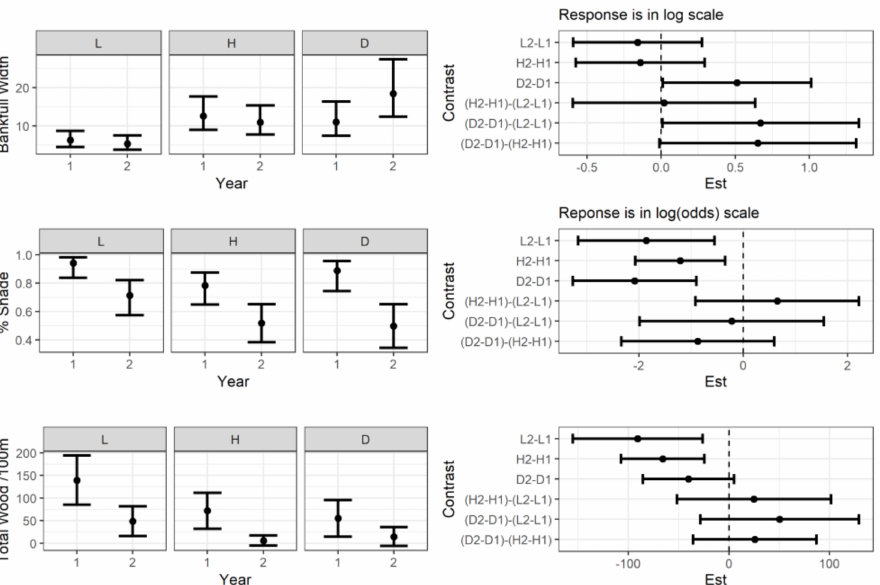
Figure 2. Estimated marginal means with 90% C.I.s of bankfull width, % shade, and total in- channel wood before and after 2007 disturbance at low flood ( L ), high flood ( H ), and debris flow ( D ) disturbance categories (left) and contrasts between years (1–3, top) and relative differences between categories (4–6, bottom) (right).